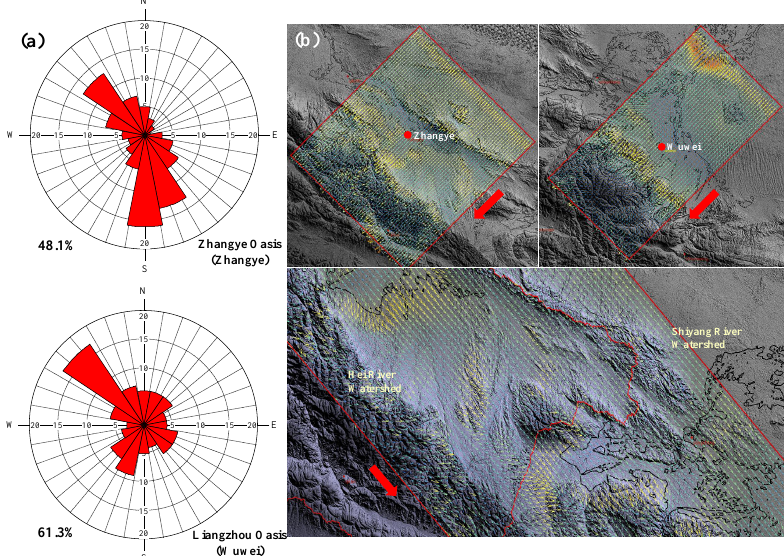
Figure 7. Wind direction frequency roses for Zhangye and Liangzhou oases (a) and calculated wind velocity and direction using a computa- tional fluid-flow dynamics model ( b ; Lopes, 2003) for prevailing wind directions from the north-east (upper diagrams) and north-west (lower diagram) and July peak near-surface air temperatures (Fig. 2b). Percent values in (a) represent the portion of the time during the growing season that prevailing winds are in directions that will lead to the production of orographic precipitation in the Qilian Mountains (i.e. winds from the north-west to east-south-east directions).